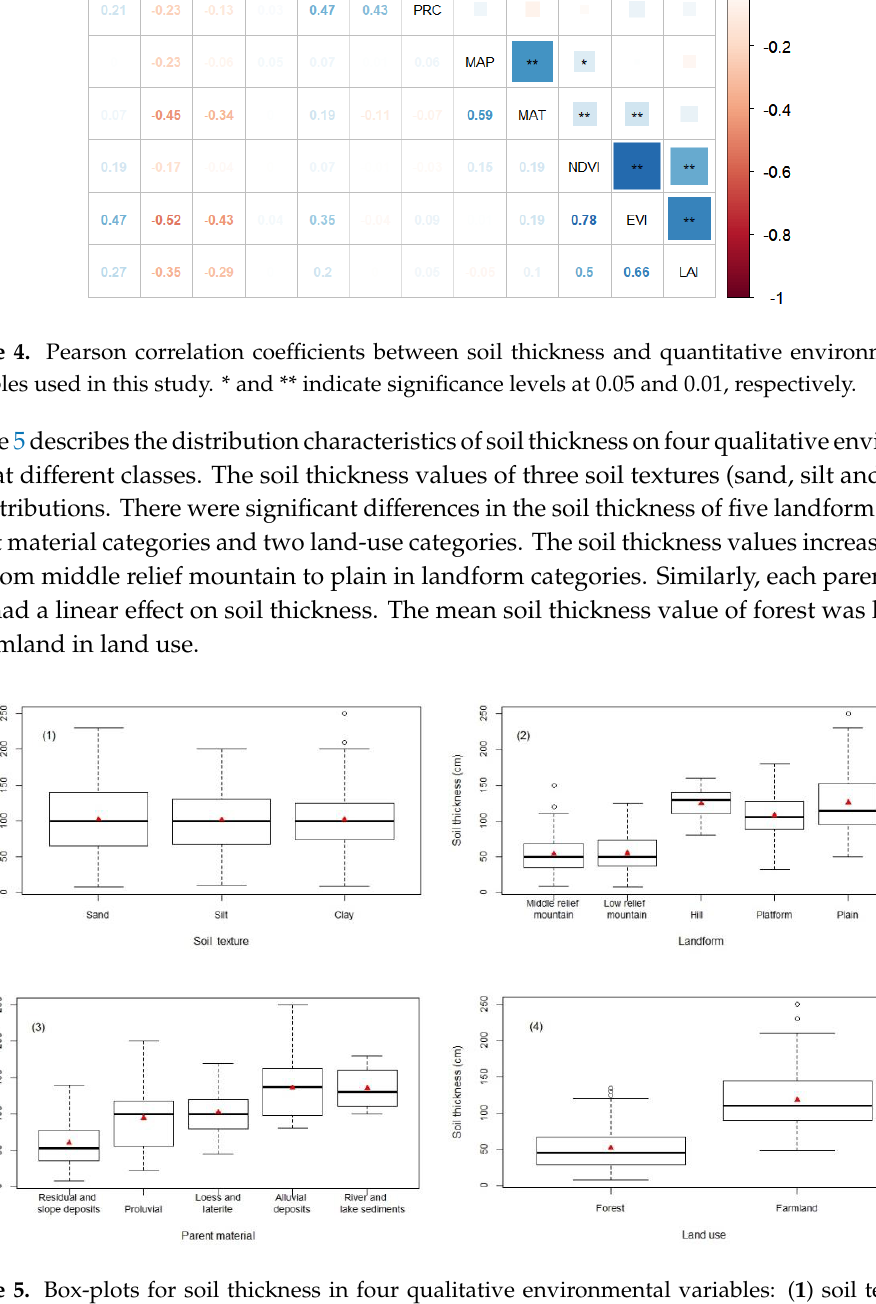
Figure 5. Box-plots for soil thickness in four qualitative environmental variables: ( 1 ) soil texture, ( 2 ) landform, ( 3 ) parent material, and ( 4 ) land use.